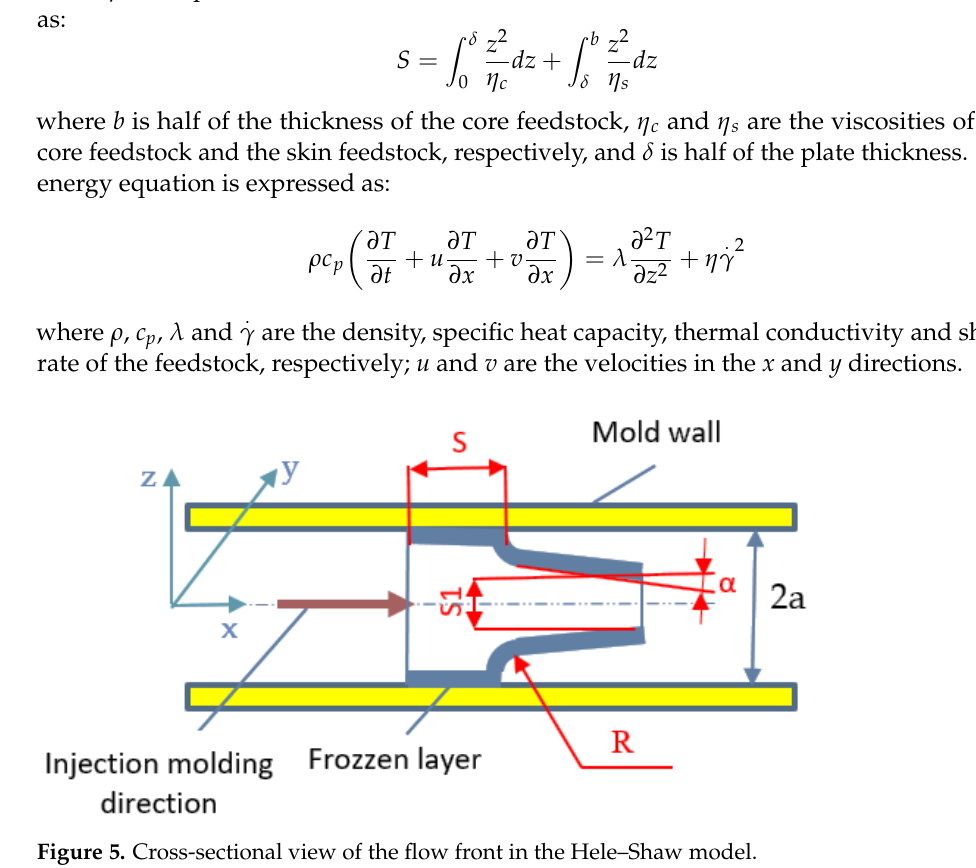
Figure 5. Cross-sectional view of the flow front in the Hele – Shaw model.